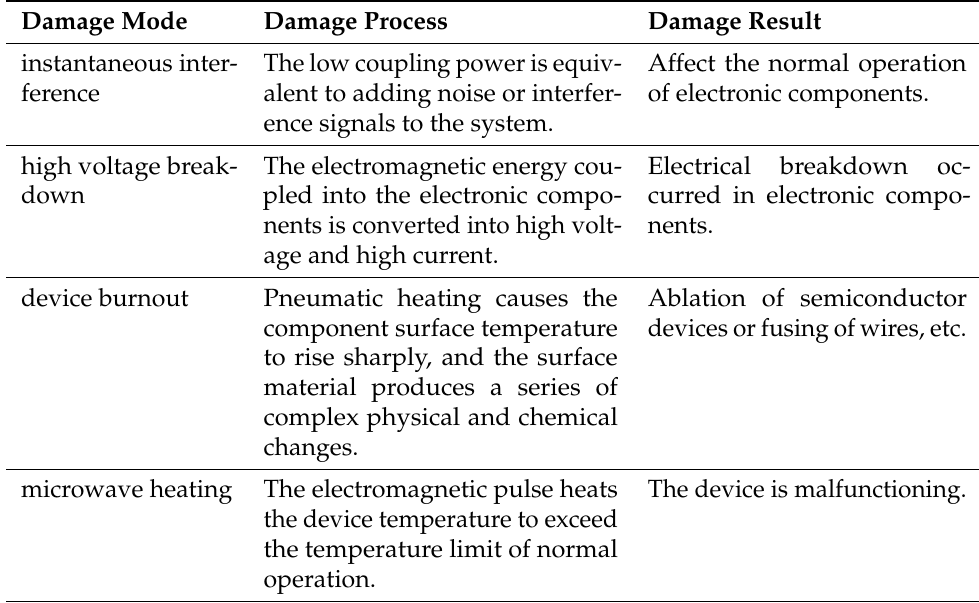
Table 3. Electromagnetic pulse damage classification of electronic